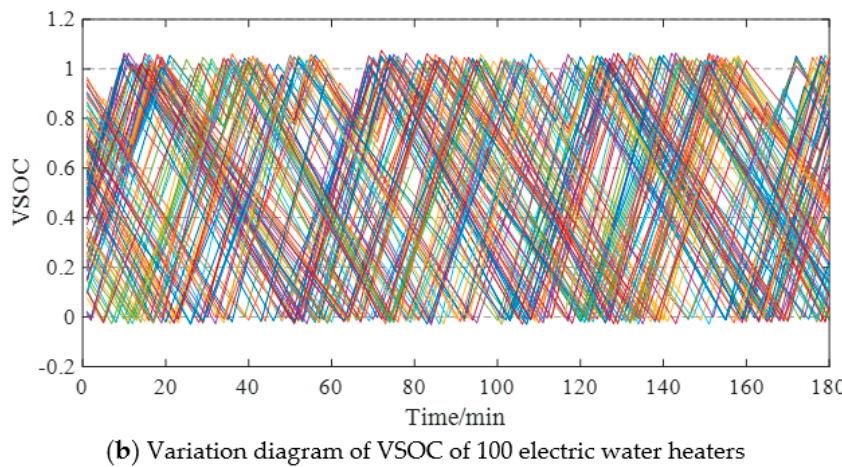
Figure 15. Control effect of optimized control strategy under fluctuating power shortage.